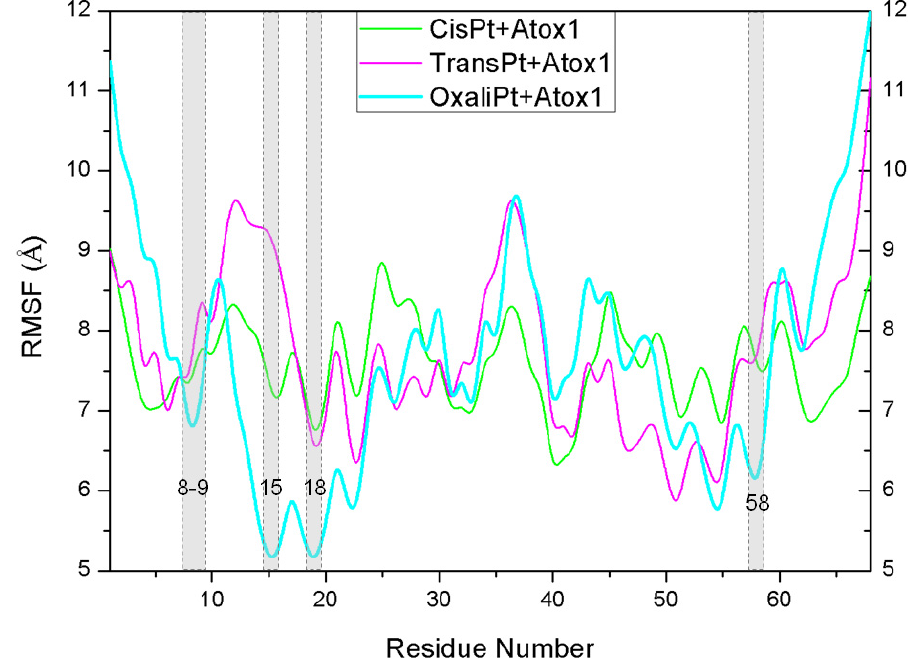
Figure 7. The fluctuations of residues for the CisPt + Atox1 ( green ), TransPt + Atox1 ( magenta ) and OxaliPt + Atox1 ( cyan )